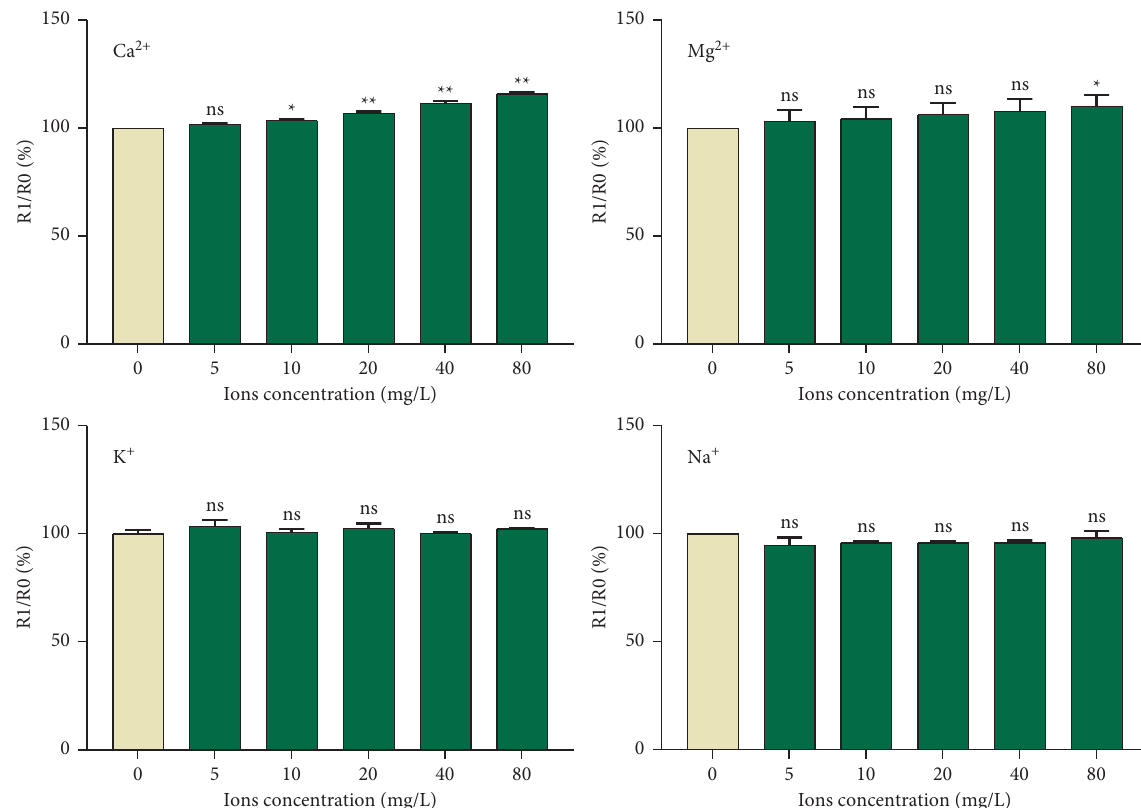
Figure 3: Effect of different metal ions on the antioxidant activity of EGCG solutions of 50mg/L. R 1/ R 0: the antioxidant activity of EGCG solution added with/without metal ion, respectively. The marks above the column show the significance of differences, ns indicates p > 0 . 05, ∗ indicates p < 0 . 05, and ∗∗ indicates p < 0 . 01.